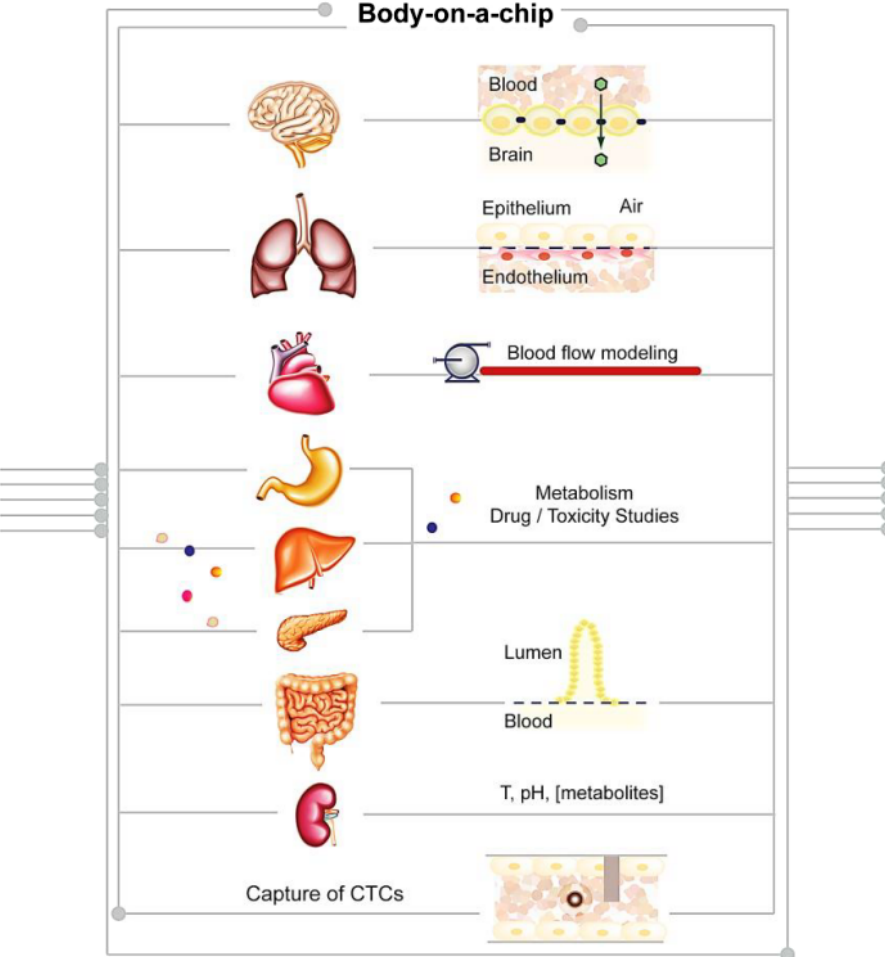
Fig. 4. Schematic representation of a body on chip approach. 39 This ¯gure is reproduced from Perestrelo et al. , 39 which is a distributer under a Creative-Commons license (CC-BY 4.0). http://creativecommons.